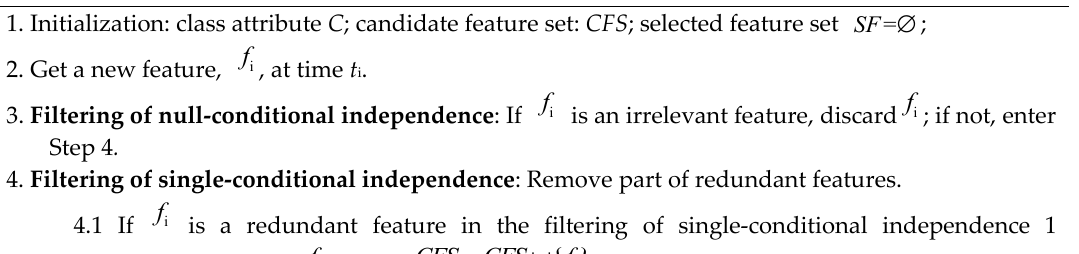
Figure 2. Features filtered using conditional dependence.